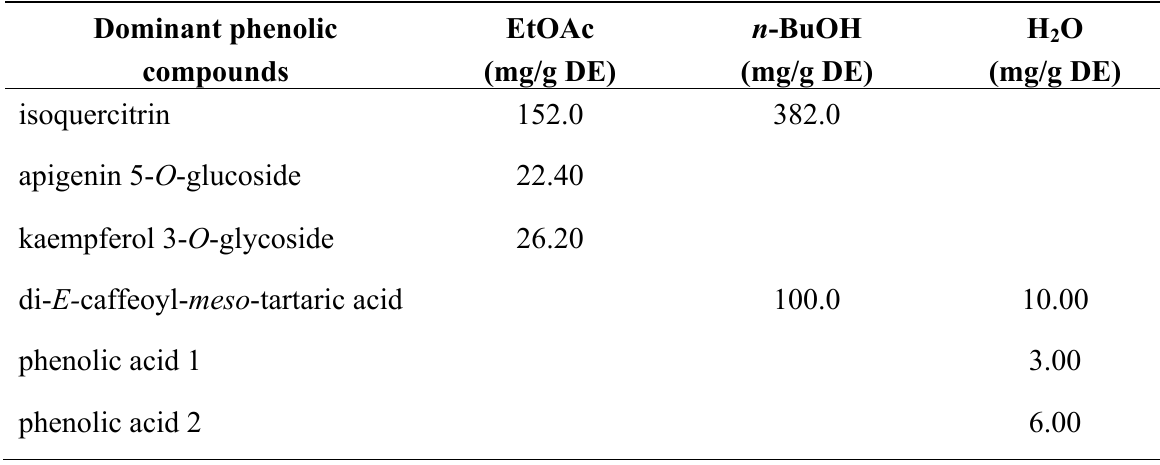
Table 1. The results of HPLC-DAD phenolic identification and quantification of